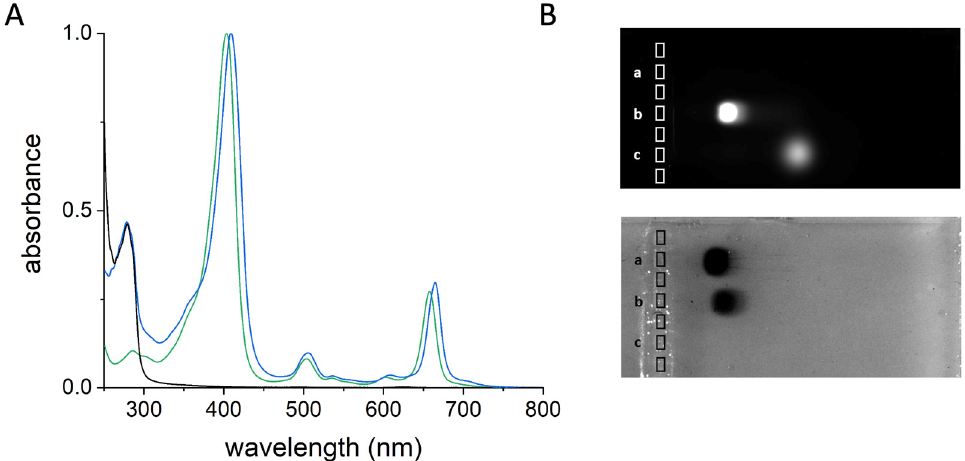
Figure 5. ( A ) The UV-Vis spectra of HSA (black line), Ce6 (green line), and Ce6@HSA (blue line); ( B ) the agarose gel electrophoresis of (a) HSA, (b) Ce6@HSA, and (c) Ce6. The gel images were acquired both before staining, in fluorescent mode (top), and after staining with Coomassie blue, in colorimetric mode (bottom).